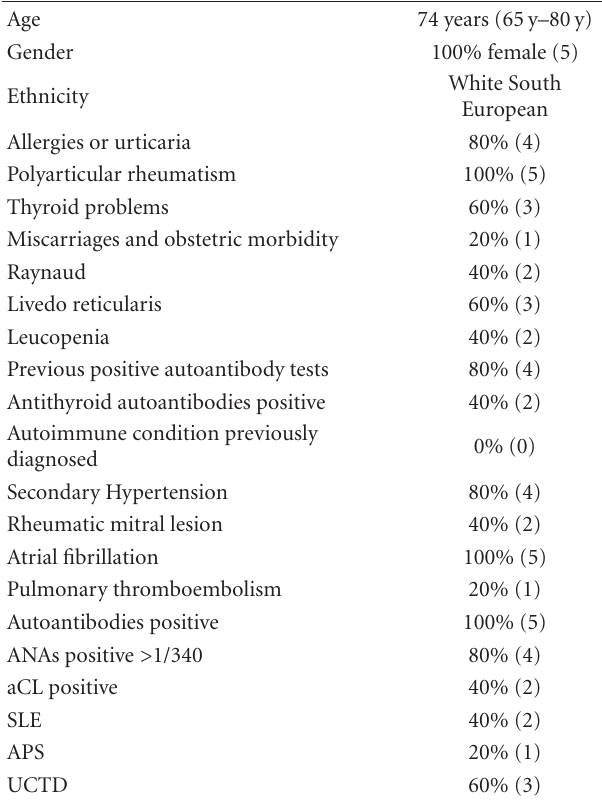
Table 1: Cases characteristics ( n =